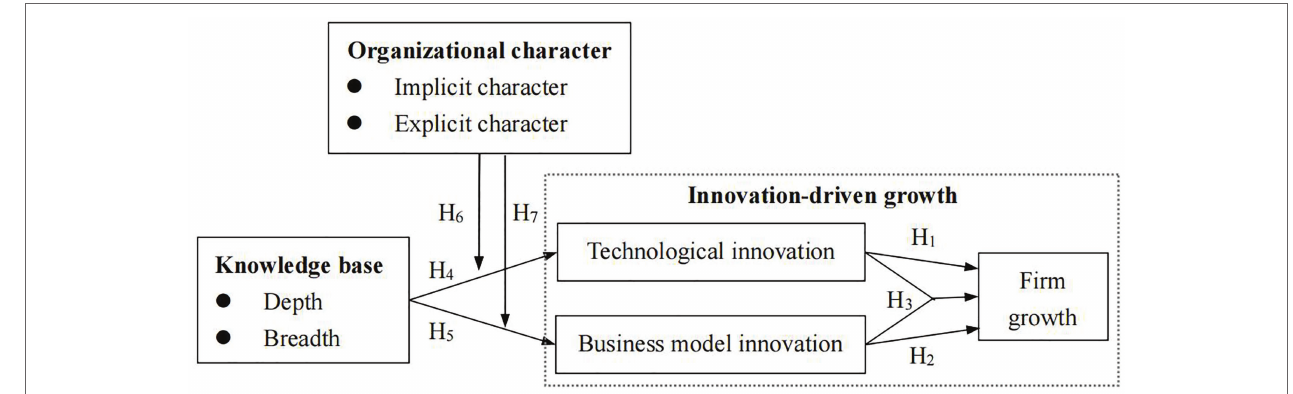
FIGURE 1 | The framework of this